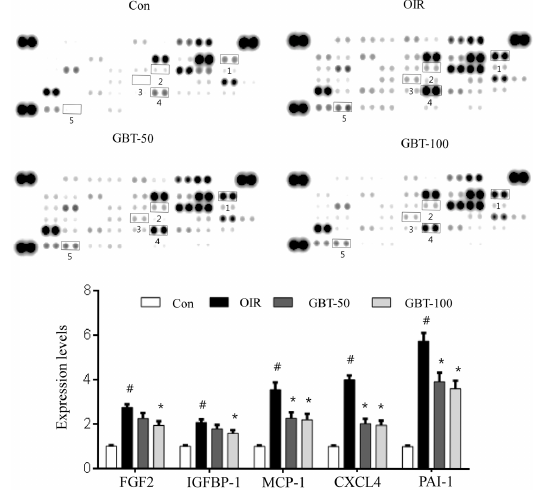
Figure 3. Expression of retinal angiogenesis-related proteins in OIR mice. Pro- and anti-angiogenic factor expression in the retina was analyzed using protein arrays and quantified using ImageJ software. The negative control is located in the lower right corner of the arrays, and the positive controls are located in other three corners. The proteins for which expression was modulated in GBT-treated retinas are indicated by numbers. Con, normal control mice; OIR, saline-treated OIR mice; GBT-50, OIR mice treated with 50 mg/kg GBT; and GBT-100, OIR mice treated with 100 mg/kg GBT. 1: FGF2, fibroblast growth factor 2; 2: IGFBP-1, insulin-like growth factor binding protein 1; 3: MCP-1, Monocyte Chemoattractant Protein-1; 4: CXCL4, chemokine (C-X-C motif) ligand 4; 5: PAI-1, Plasminogen activator inhibitor-1. Data are represented as mean ± SE ( n = 4). # p < 0.0001 for control group vs. OIR group; * p < 0.05 for OIR group vs. GBT-treated group.